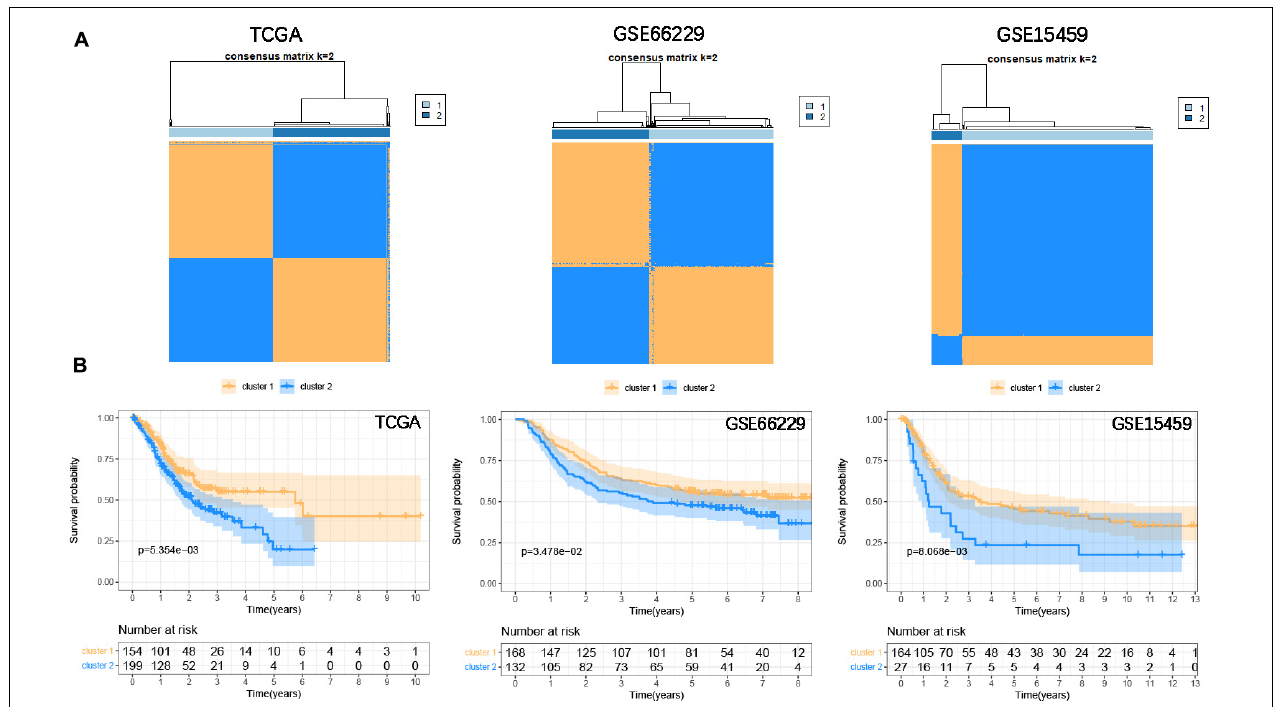
FIGURE 6 | Identify the molecular subtypes of GC based on the prognostic-related focal adhesion genes. (A) Identify two different GC molecular subtypes in the training and validation cohorts through the consensus clustering method. (B) Kaplan-Meier curve is depicted to observe the relationship between molecular subtypes and the overall survival of GC patients in the training and validation